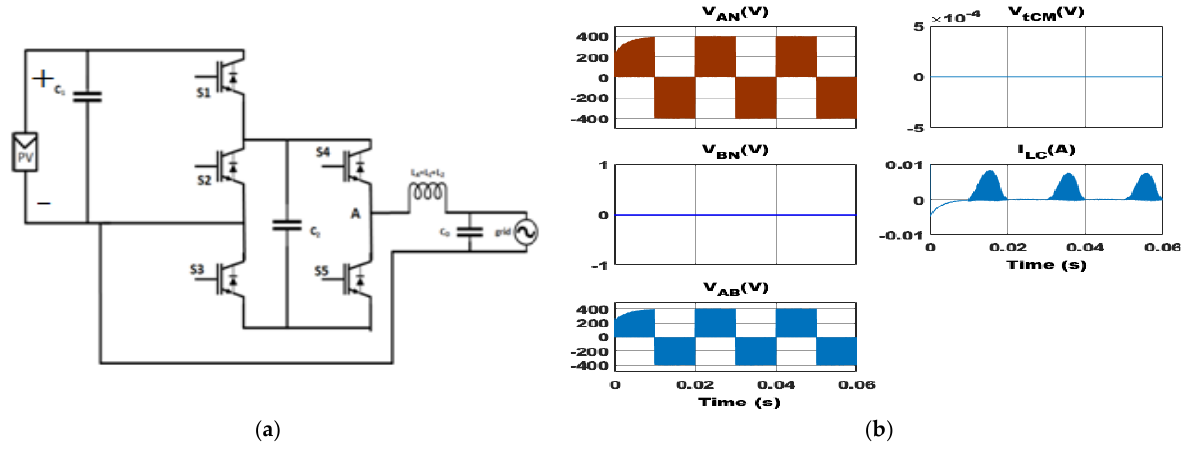
Figure 19. Virtual DC Bus topology: ( a ) circuit structure; ( b ) simulation results.